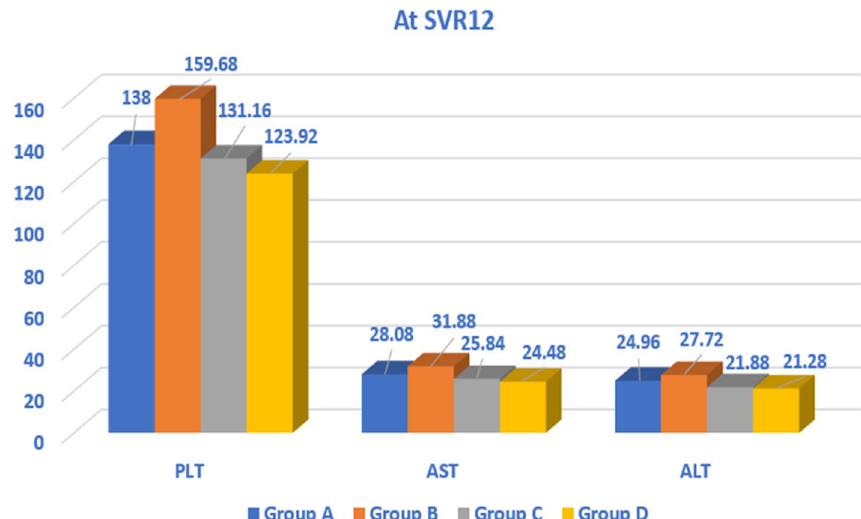
Fig. 1 Comparison between the studied groups regarding PLT, AST, and ALT levels at SVR12